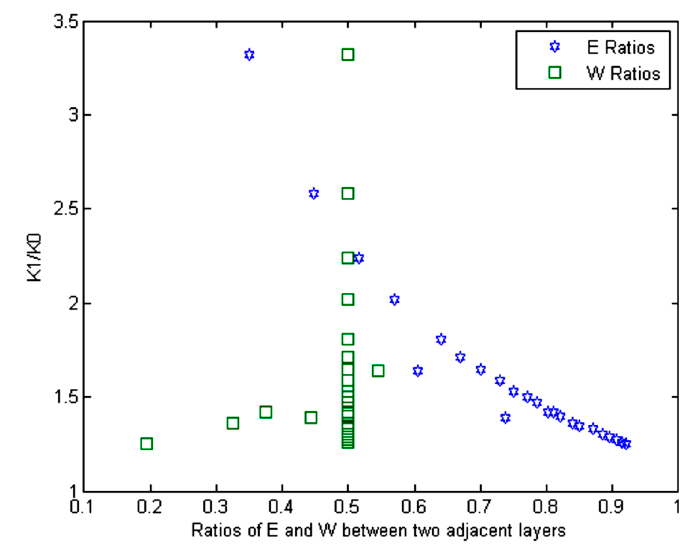
Figure 15. Impact of the ratios of E and W on the normalized stress intensity factor, K 1 / K 0 . Table 3. Normalized SIF K 1 / K 0 for different Double Layer (DL) and Hybrid TBC systems.